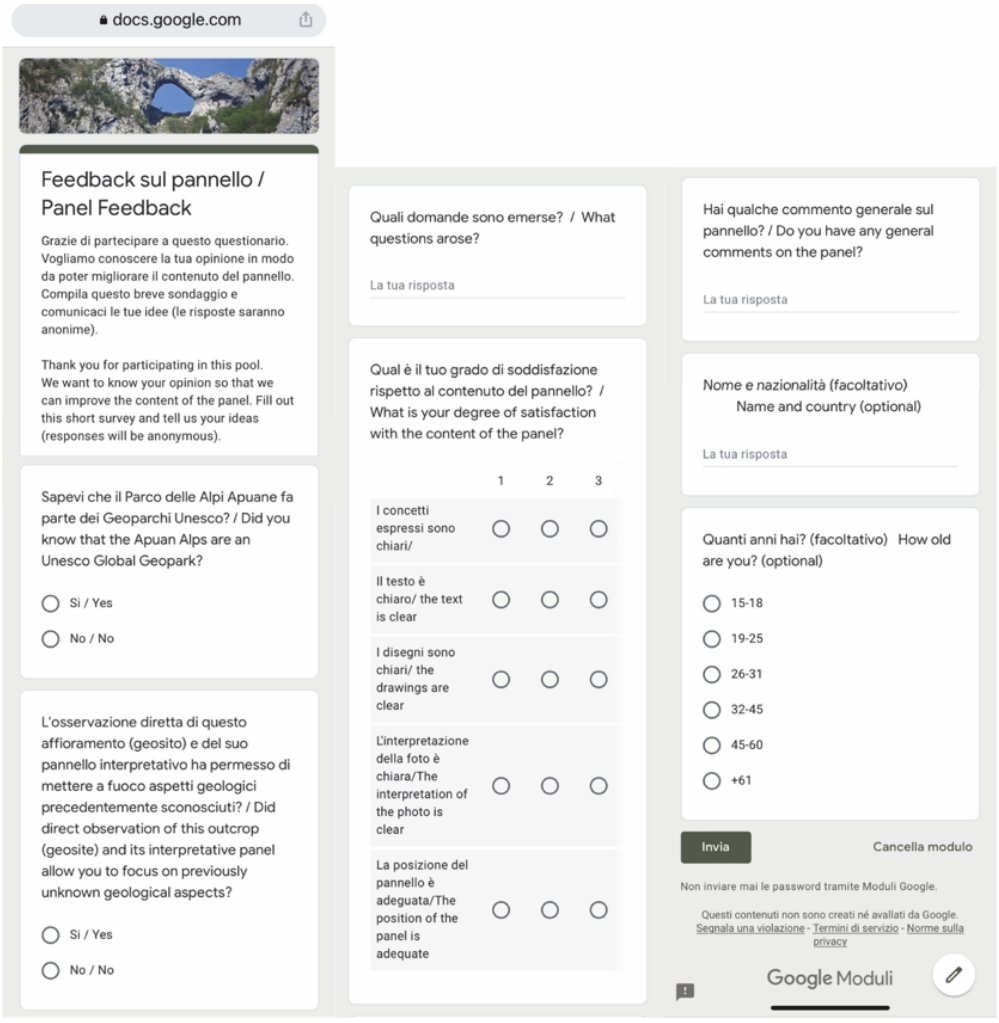
Figure 9. Screenshot of the quick survey that the readers can complete about the quality and clarity of the interpretative panel.